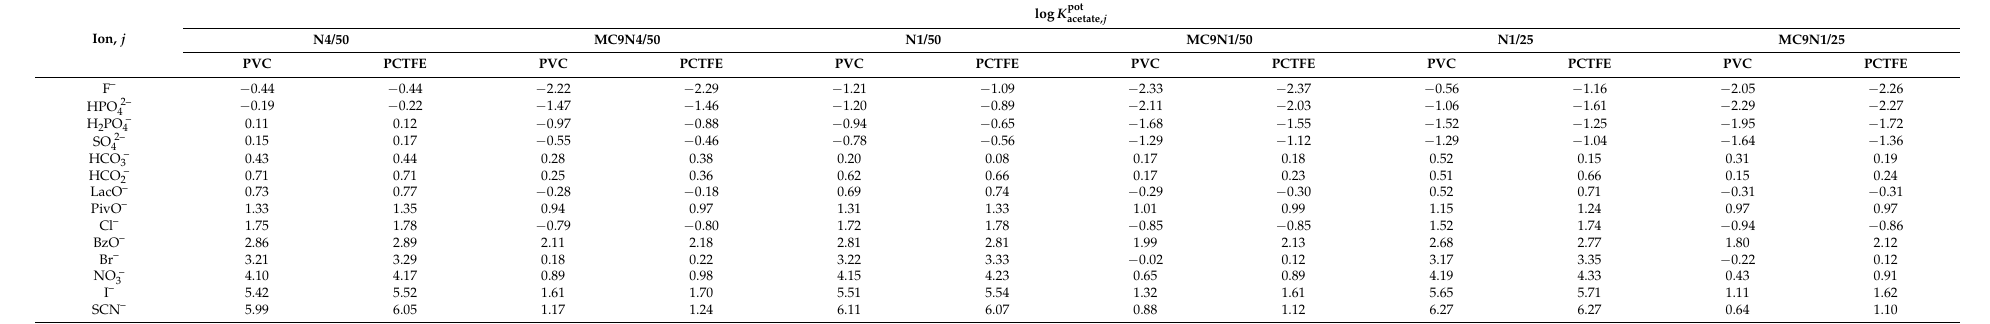
Table A11. Average potentiometric selectivity coefficients determined with the separate solution method ( a i = a j = 10 − 2.05 M) for sensors with membranes incorporating MC9 and plasticized with o -NPOE. The number of measurements and the number of sensors were n = 1 and k = 3, respectively. See Table A12 for standard deviations. See Table 1 for membrane compositions.